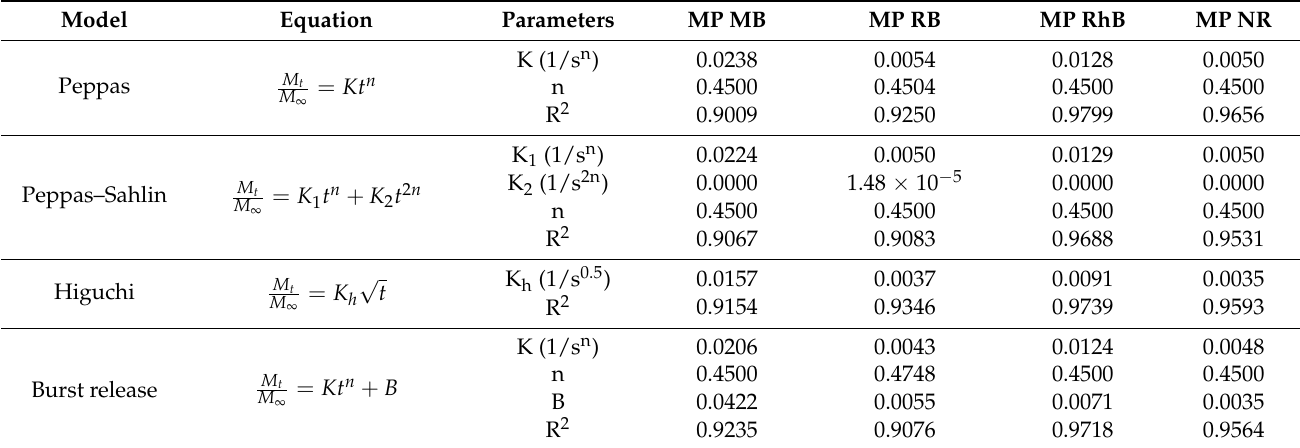
Table 2. Parameters obtained by fitting the Peppas, Peppas–Sahlin, Higuchi, and burst release models to the SF microparti- cles’ dye release